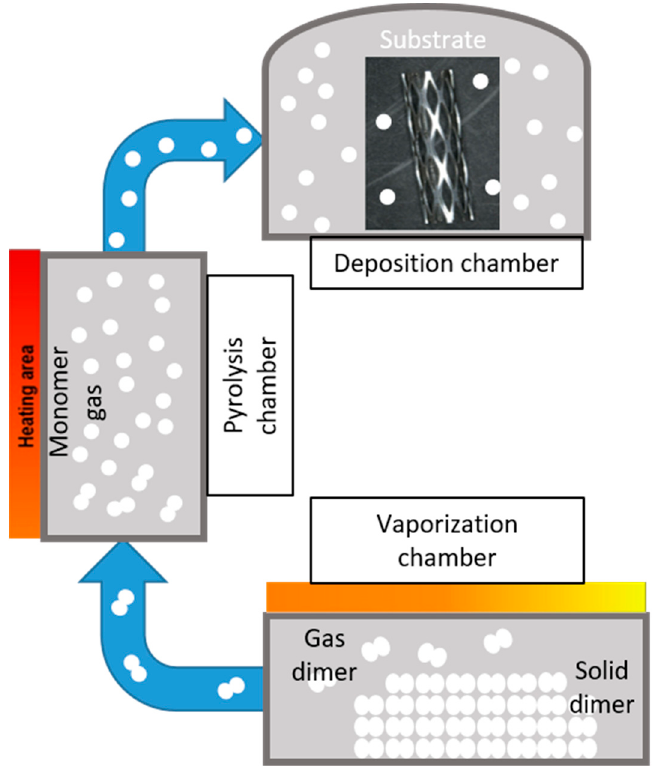
Figure 6. Illustration of the Parylene C coating procedure in a PVD.